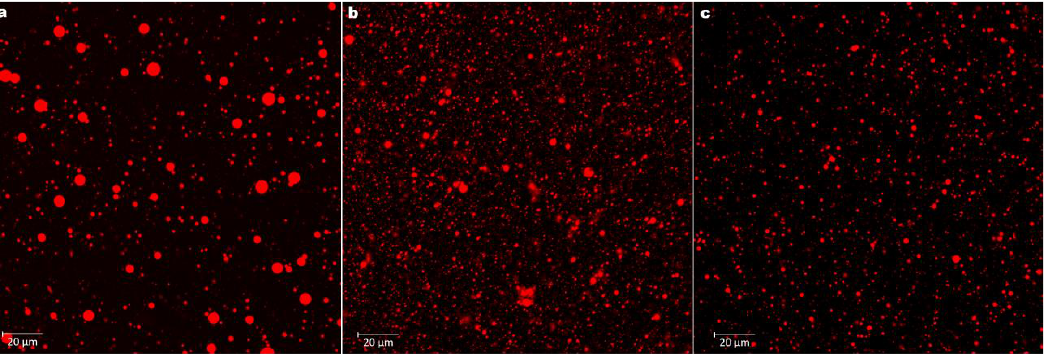
Figure 4. CLSM observations of ( a ) the control nanoemulsion (CNE) treatment, ( b ) C. reticulata leaf essential oil nanoemulsion (CrBL-EONE) treatment, and ( c ) D-limonene nanoemulsion (D-LNE) treatment.